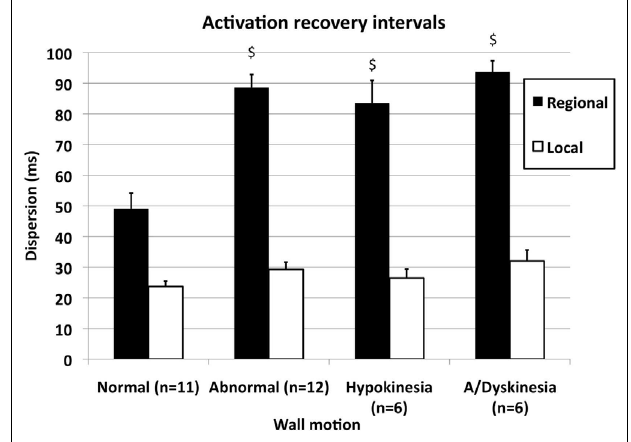
FIGURE 4 | Local (open bars) and regional dispersion (filled bars) of activation-recovery intervals (ARIs) in 11 patients with normal wall motion and in 12 patients withWMA. The patient group with WMA was subdivided into six patients with hypokinesia and six patients with akinesia or dyskinesia. See text for further explanation. $ p < 0.005 compared with normal wall motion.The subgroups